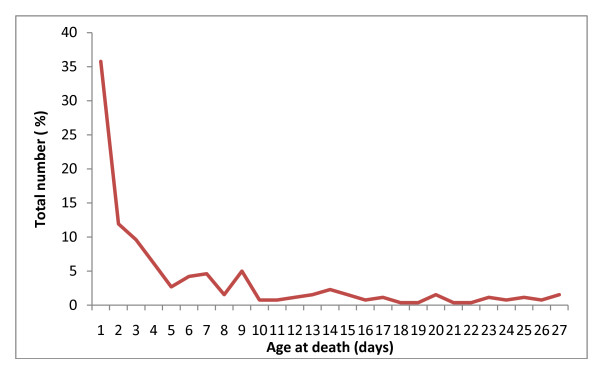
Age of neonate at death.